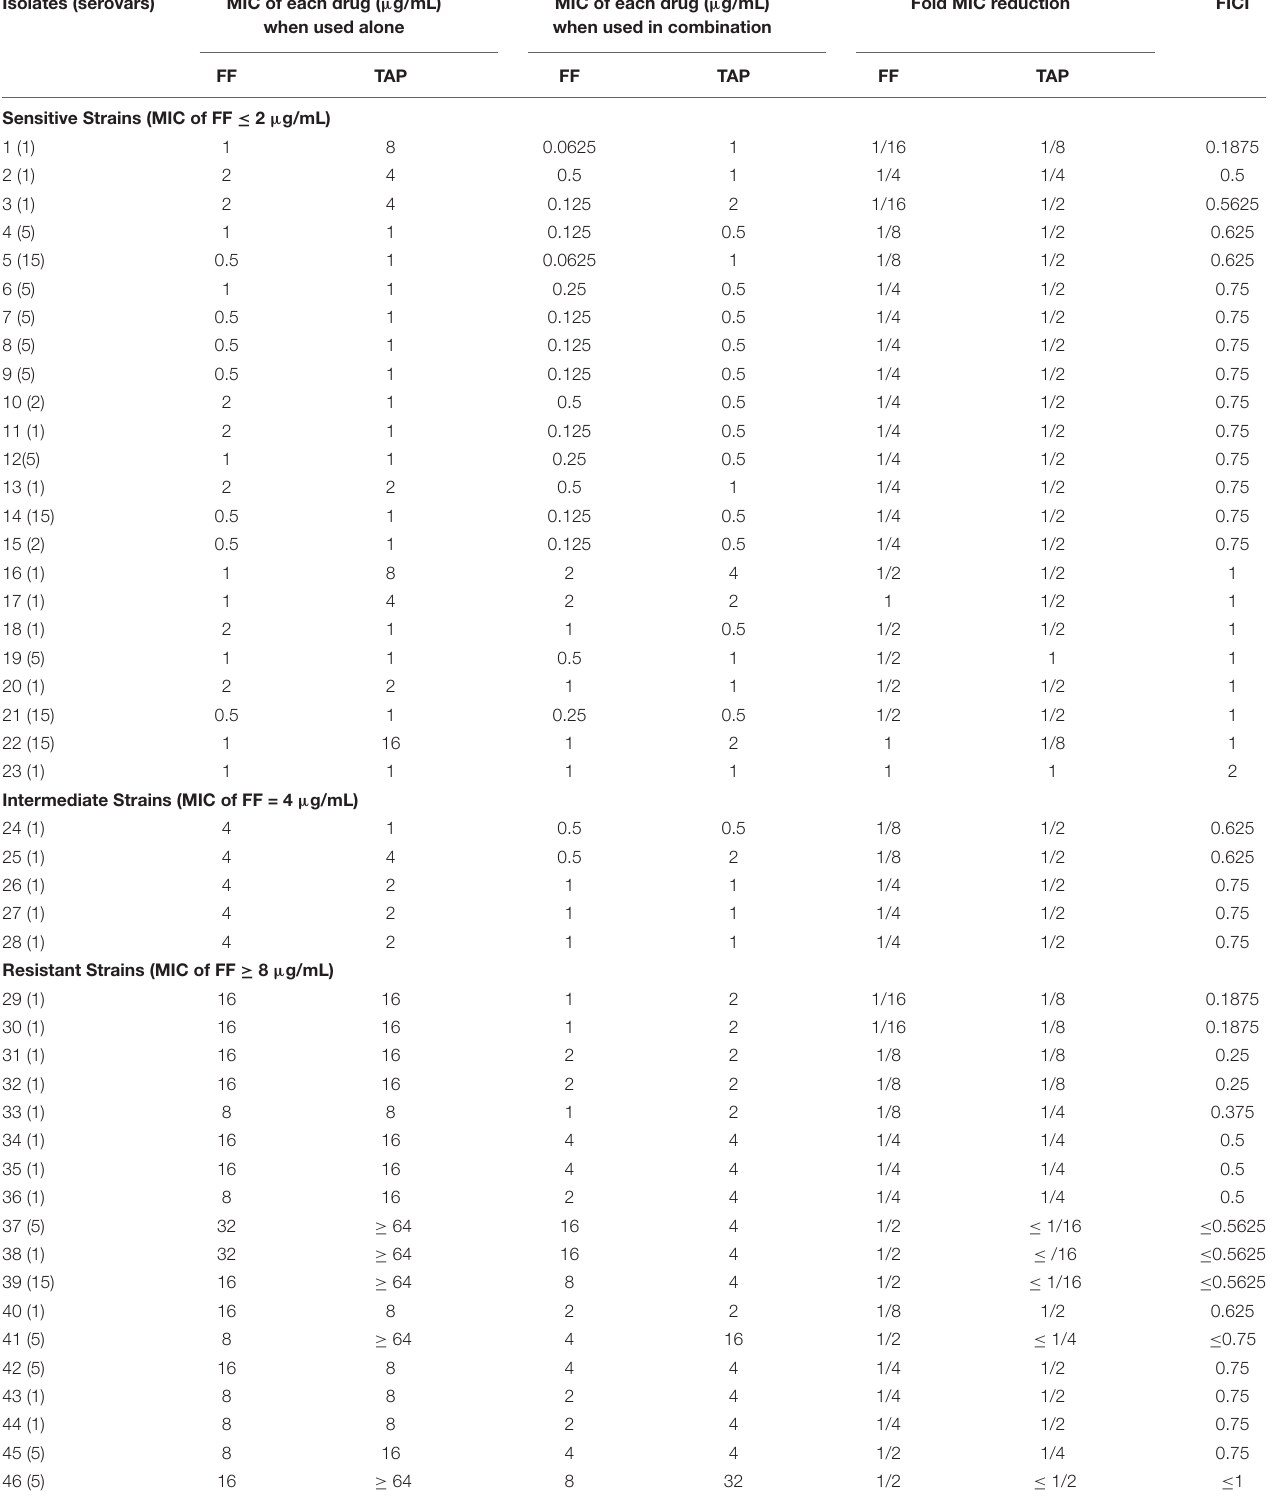
TABLE 2 | In vitro inhibitory activity of FF and TAP alone and in combination against A. pleuropneumoniae by checkerboard assay. Isolates (serovars) MIC of each drug ( µ g/mL) MIC of each drug ( µ g/mL) Fold MIC reduction when used alone when used in combination